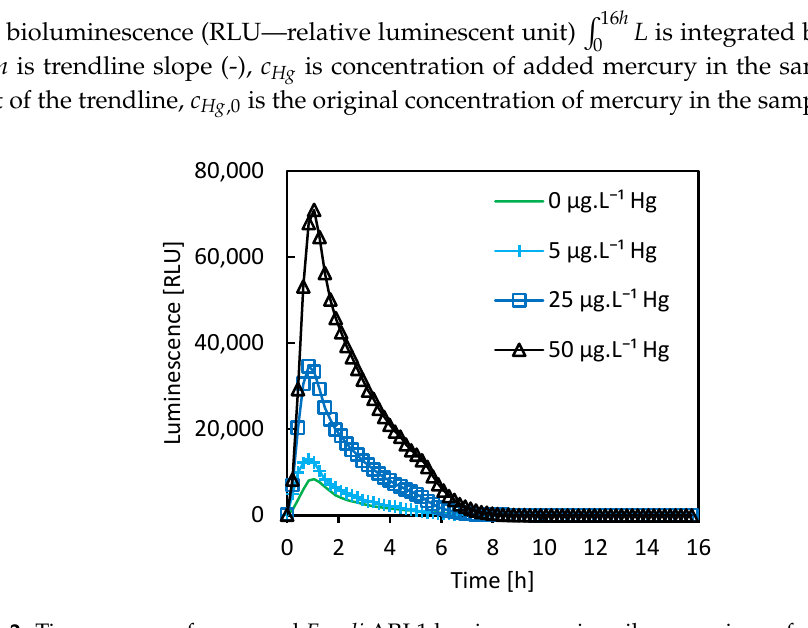
Figure 2. Time courses of measured E. coli ARL1 luminescence in soil suspensions of soil sample A with di ff erent standard additions of mercury (II) chloride.